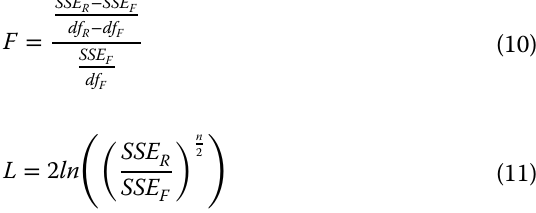
correlation in the data must be considered when devel- oping the H–D models. To compare the differences between the height-diameter relationships at the four sites of our study area, the nonlinear extra sum of squares F -test (Bates and Watts 1988; Huang et al. 2000) and the test introduced by Lakkis and Jones (Khattree and Naik 1999) were used. For this purpose, both full and reduced models were required. The full model had a different set of parameters for each site, while the reduced model shared the same set of parameters for all four sites. In this study, the reduced model is the H–D model developed in the previous step including stand variables. The full model would be extended on this by the indicator varia- ble approach (Bates and Watts 1988), i.e., extending each parameter to include an associated parameter as well as Δ 1 x 1 a dummy variable (e.g., for La Fusta) to distinguish among sites (Adame et al. 2008).